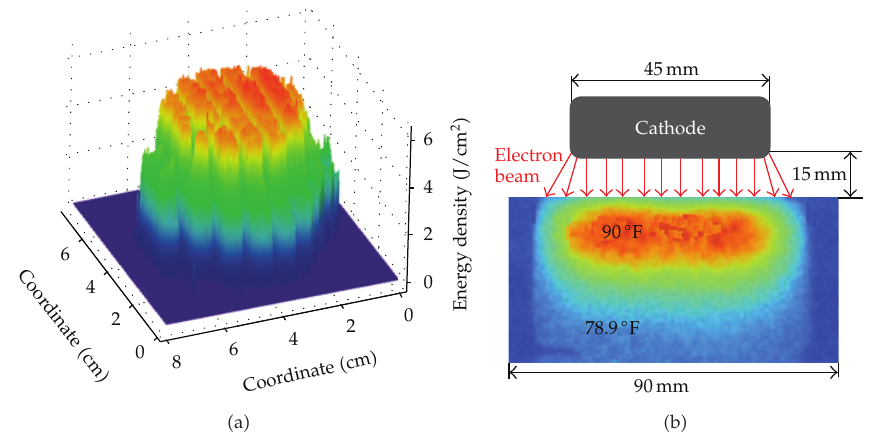
Figure 6: Distribution of the energy density over the cross-section of electron beam, measured by a radi- ochromic film, (cid:2) a (cid:3) and temperature distribution along the depth of a foam sample, measured by infrared camera (cid:2) b (cid:3)